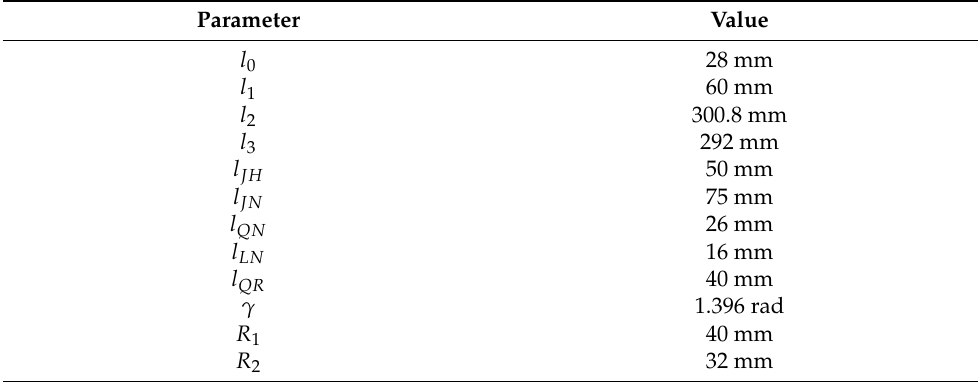
Table 1. Optimized dimensions of the compaction mechanism.